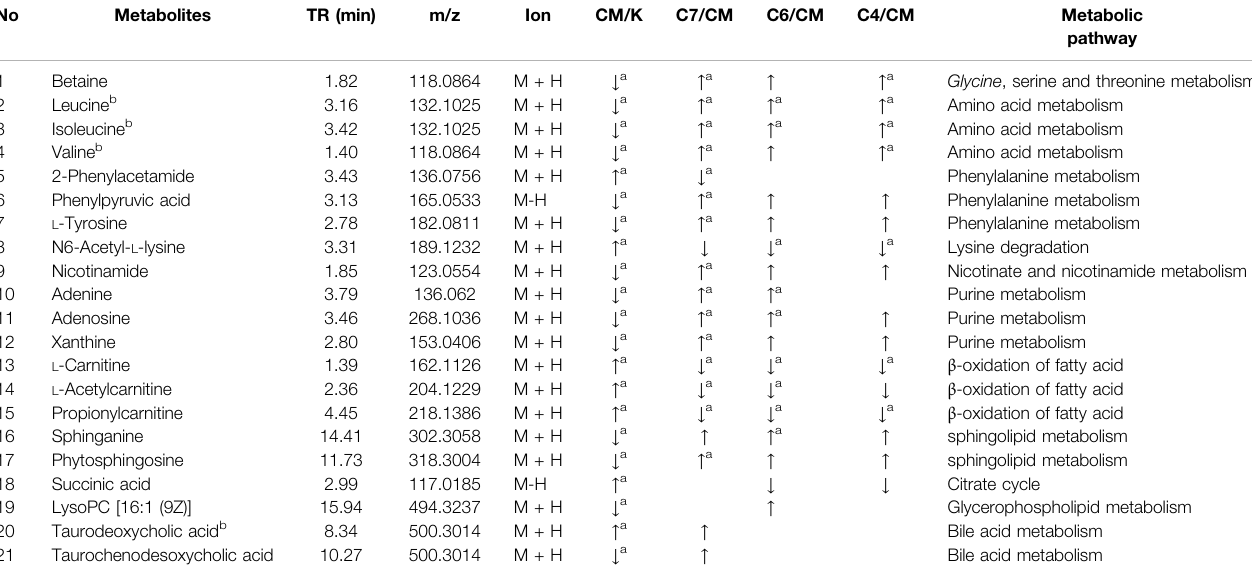
TABLE 5 | Identi fi ed differential metabolites in the liver of CUMS